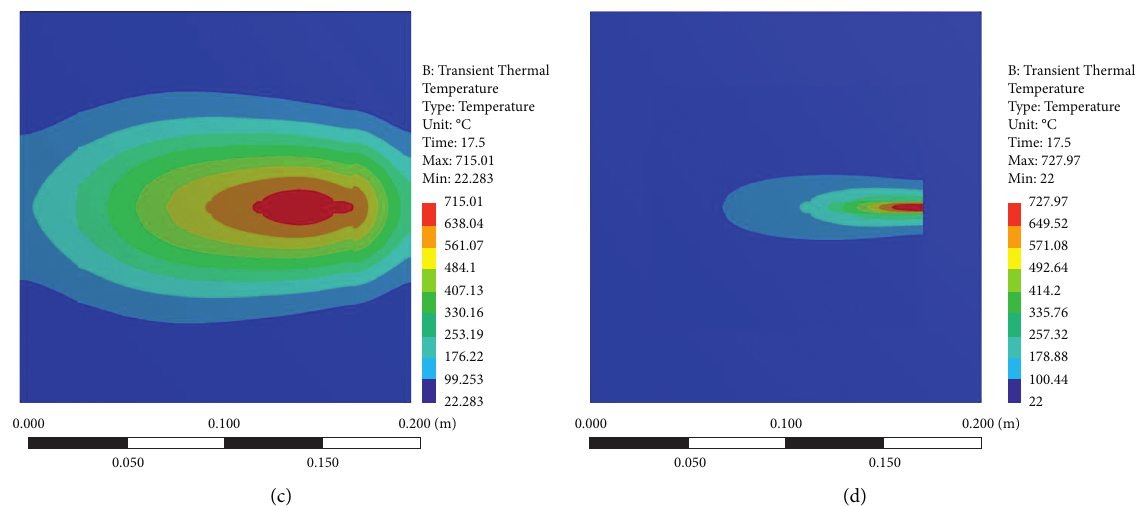
Figure 9: Temperature distribution of the deposition wall (a) and (b) without path restriction; (c) and (d) with the copper plates constrained